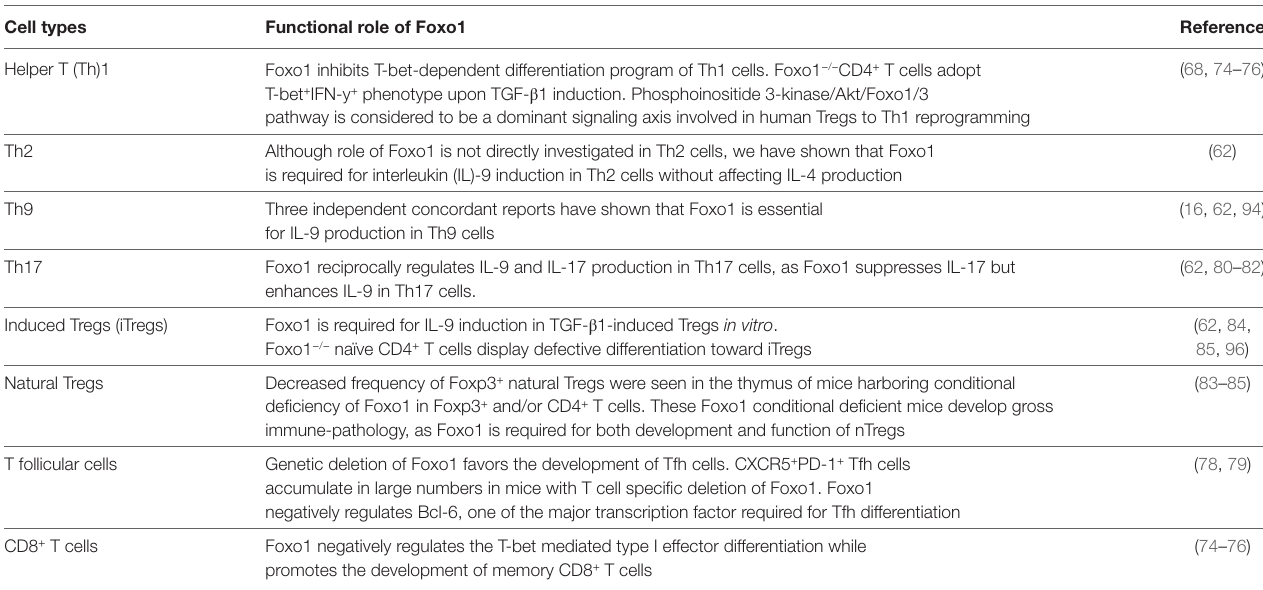
TAbLe 1 | Role of Foxo1 in effector and regulatory T